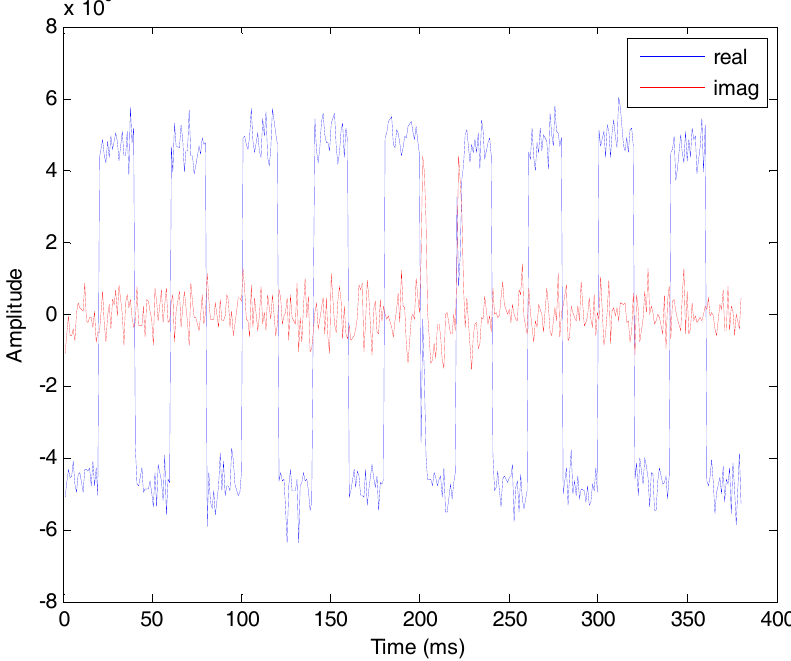
Figure 16. The differential coherent result of satellite #9.